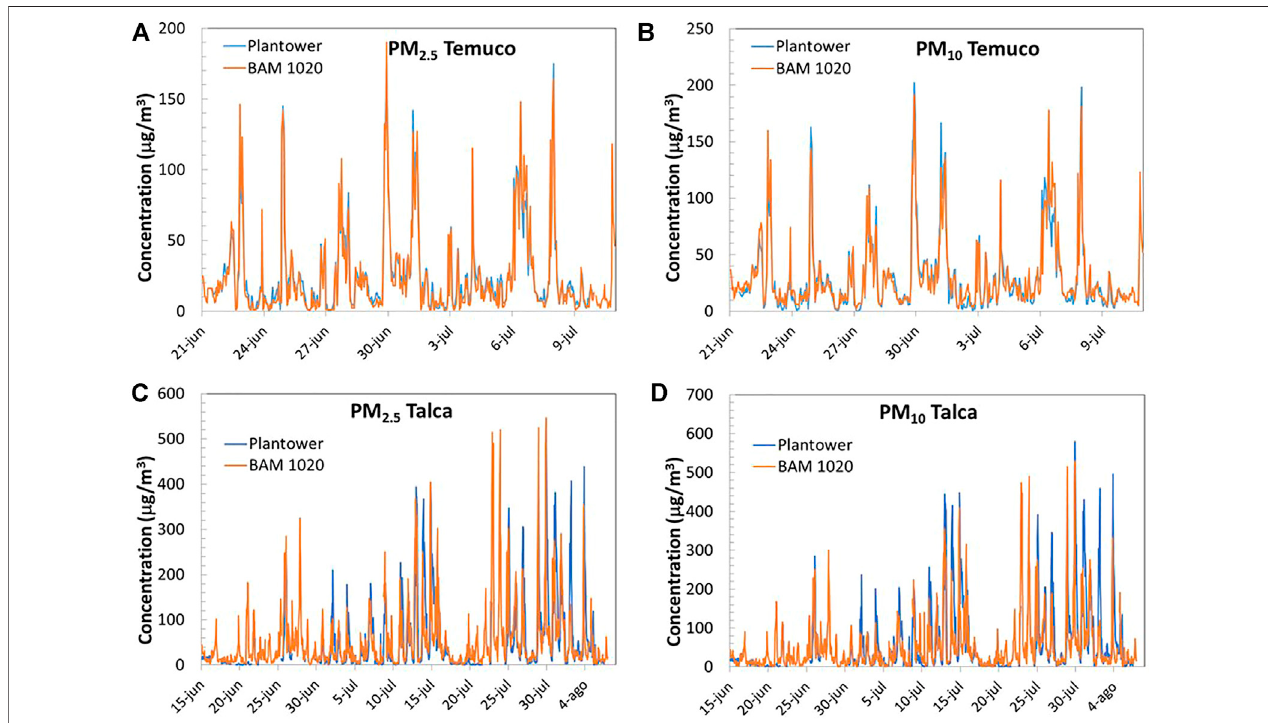
FIGURE6|(A) and (B) TimeseriesofthePlantowerandBAMinTemuco,fromJune21untilJuly26,2019. (C) and (D) TimeseriesoftheNovaFitnessandBAMin Talca, from October 1 st until November 20, 2019.